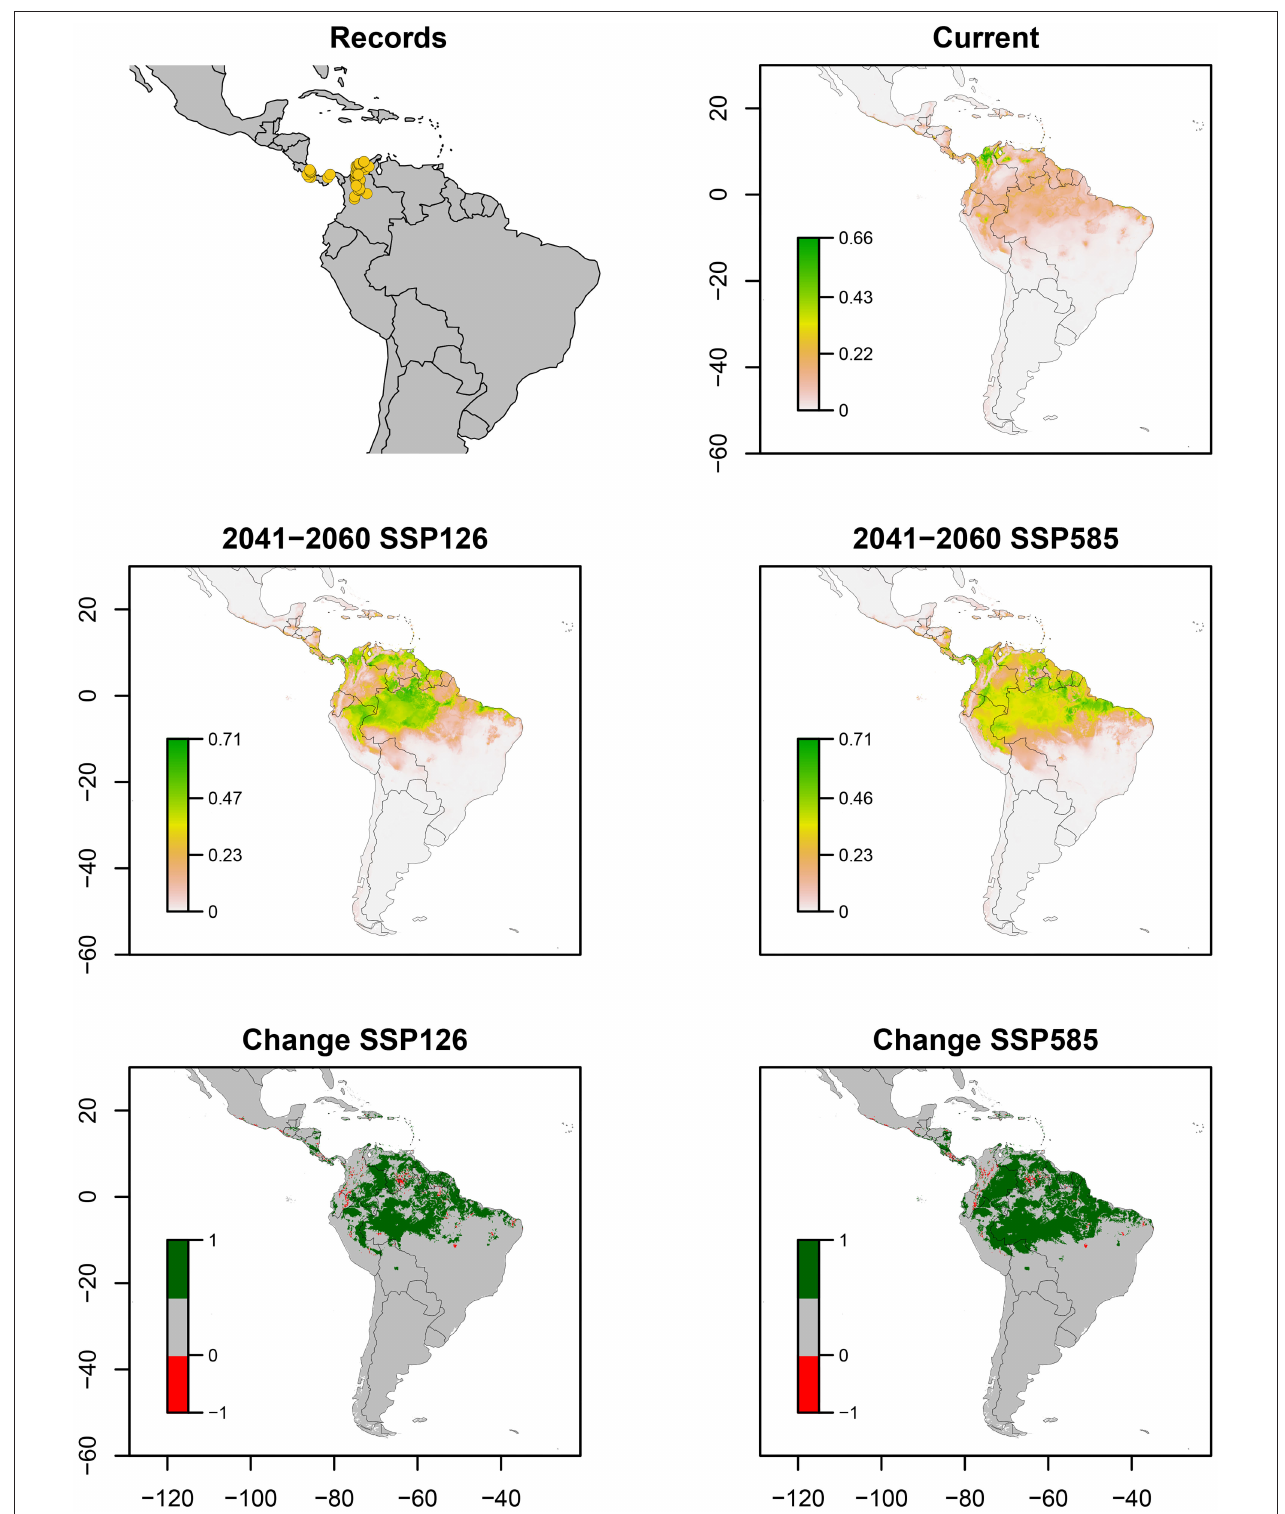
FIGURE 1 | Ecological niche models of Aeneolamia lepidior. Distribution records, current potential distribution, future potential distribution (2041–2060) under SSP126 and SSP585 scenarios, and comparison between current and future scenarios (change SSP126 and SSP585). The scale shows the habitat suitability being 1 = higher suitability. Scale in change maps − 1 = possible extinction and 1 = possible